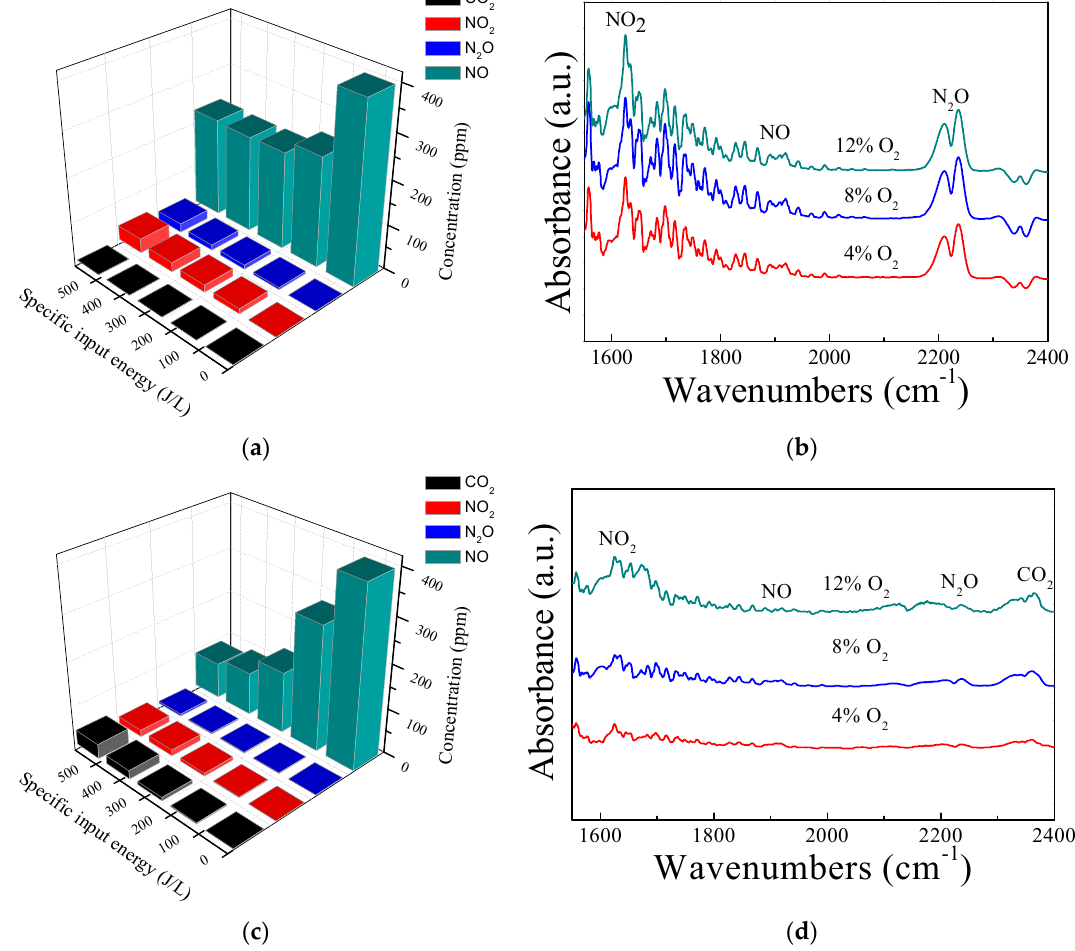
Figure 5. The product concentration and Fourier transform infrared spectroscopy (FTIR) spectra observed in different systems over V 2 O 5 –WO 3 /TiO 2 with different O 2 and SIE. ( a , b ): DBD–NH 3 –SCR, ( c , d ): DBD–NH 3 –CH 4 –SCR. Feed gas composition: 400 ppm NO, balance N 2 and 90 ppm NH 3 in DBD–NH 3 –SCR, 45 ppm CH 4 and 45 ppm NH 3 in DBD–NH 3 –CH 4 –SCR.